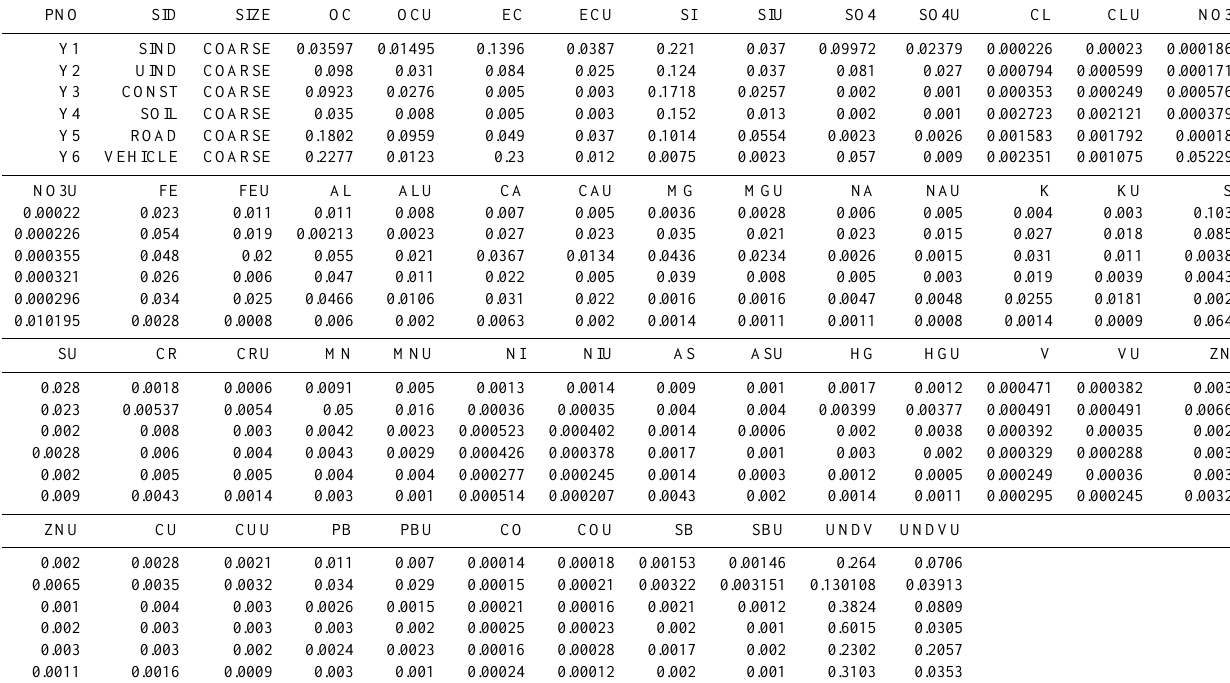
Table 4. Source profile for all